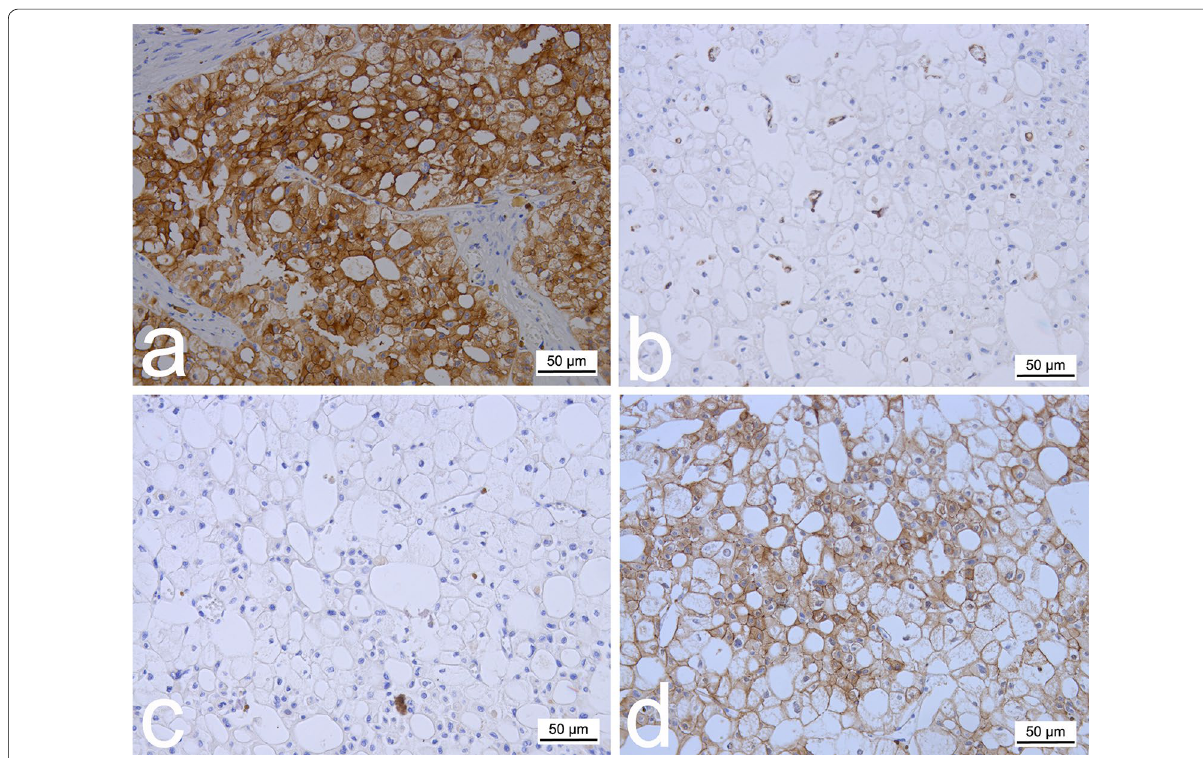
Fig. 4 Immunohistochemical examination of the tumor with specific antibodies. Immunohistochemical staining of the tumor section shows a strong positivity for cytokeratin 7 in both the cytoplasm and membrane, b negative Vimentin expression, c negative CD10 expression in both the cytoplasm and membrane, and d middle to strong positivity for erythropoietin (EPO) in the cytoplasm. The results confirmed the diagnosis of chro- mophobe renal cell carcinoma and EPO production of the tumor